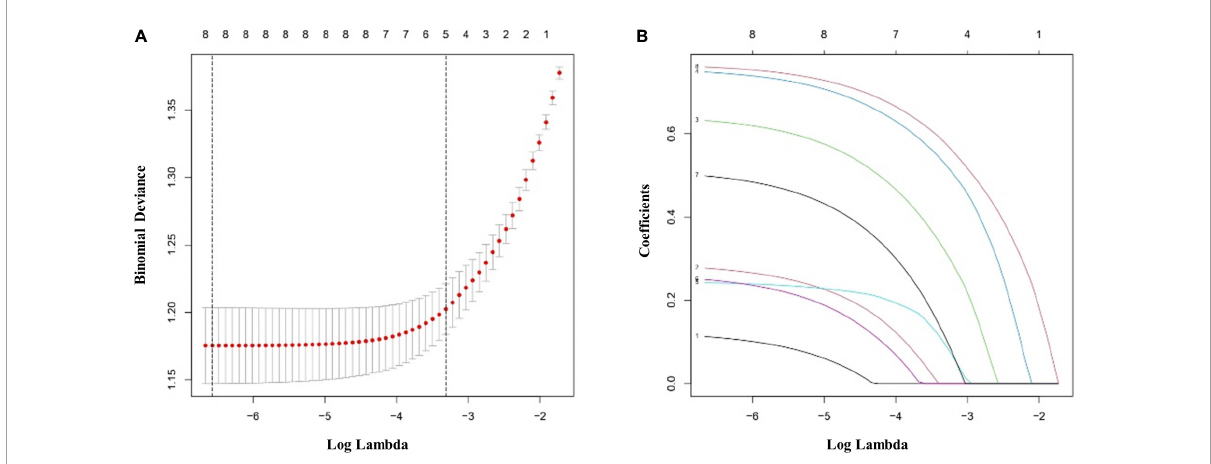
FIGURE3 Clinical and demographic ischemic stroke (IS) risk factors in the male population according to the least absolute shrinkage and selection operator (LASSO) binary logistic regression model. (A) Tenfold cross-validation based on the minimum criterion was used to find the optimal parameter (lambda) selection for the LASSO model. A plot of the partial likelihood deviance (binomial deviance) curve versus log(lambda) is shown. The dashed vertical lines were plotted based on the optimal minimum criteria and 1-SE of the minimum criteria (1-SE criteria). (B) The eight feature LASSO coefficient profiles. A coefficient profiler was generated based on the log(lambda) sequence. A vertical line was plotted using the value chosen by the 10-fold cross-validation. The optimal lambda was defined as the value that yielded non-zero coefficients for all eight features. (SE, standard error; LASSO, least absolute shrinkage and selection